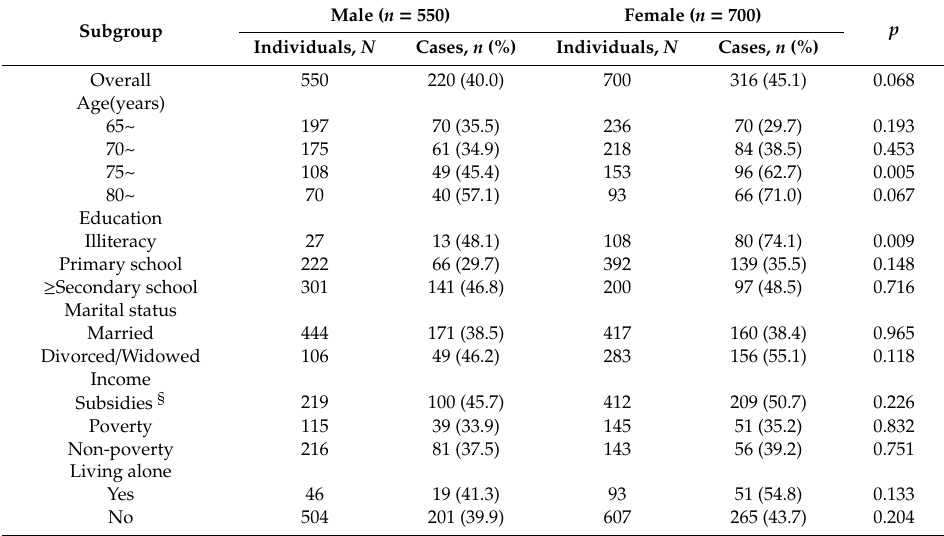
Table 3. Subgroup analysis of cognitive impairment among males and